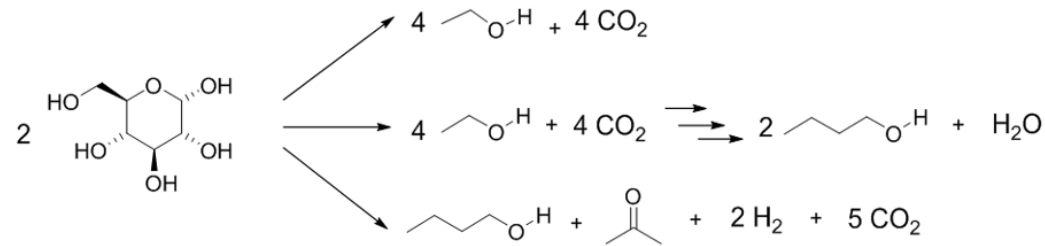
Figure 2. Acetone–butanol–ethanol (ABE) fermentation by clostridia Figure 2. Acetone – butanol – ethanol (ABE) fermentation by clostridia [84,142 – 148].